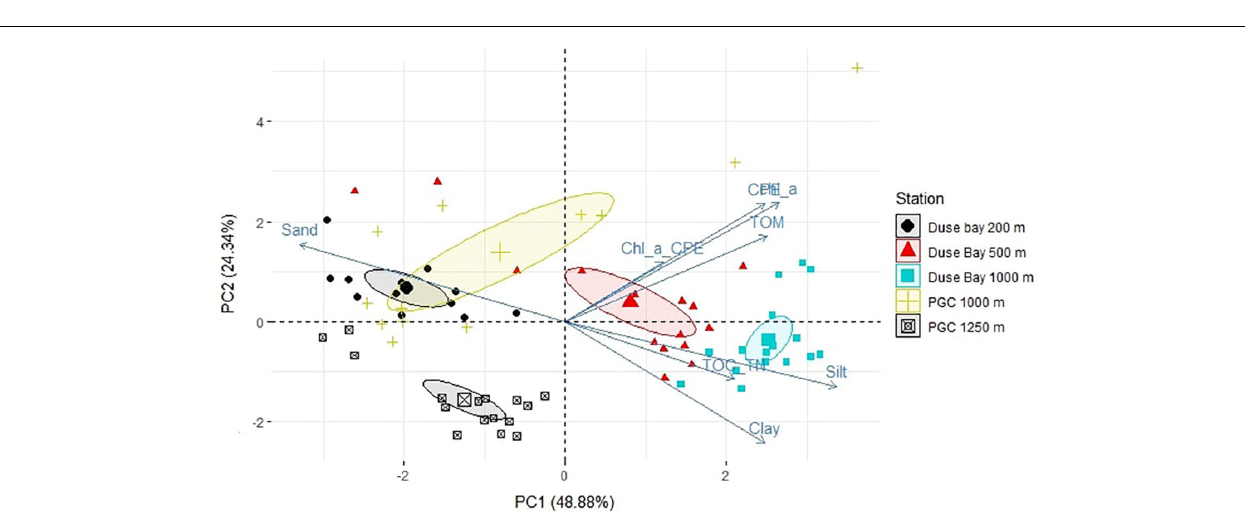
FIGURE 3 | Principal component analysis (PCA) of a subset of environmental characteristics of the sediment of all layers combined (i.e., 0–2, 2–4, 4–6, and 6–8 cm). Particularly, Chlorophyll a, CPE, Chl:CPE ratio, TOM, TOC:TN ratio, Clay, Silt and Sand parameters were considered. Confidence ellipses were plotted around group mean points, represented as larger symbols on the